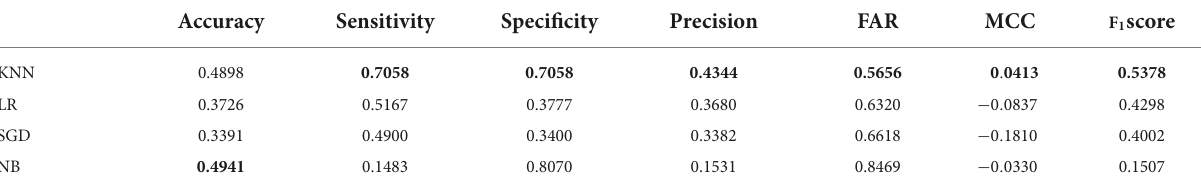
Accuracy Sensitivity